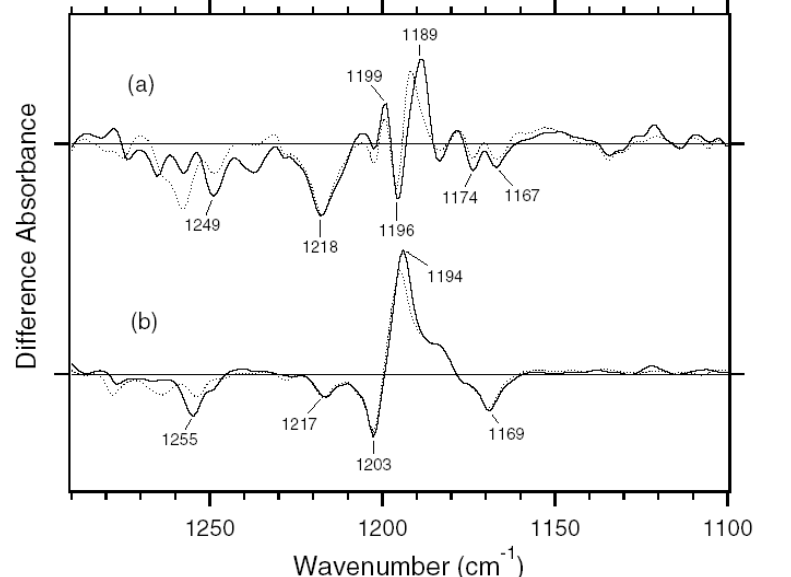
Figure 8. The ASR minus ASR (a) and the BR minus BR (b) spectra in K K the 1,290–1,100 cm -1 region, which correspond to C-C stretching vibrations and N-H in-plane bending vibrations of the retinal chromophore. The sample was hydrated with H O 2 (solid lines) or D O (dotted lines). One division of the y-axis corresponds to 0.004 2 absorbance units. This figure is reprinted with permission from Furutani et al.